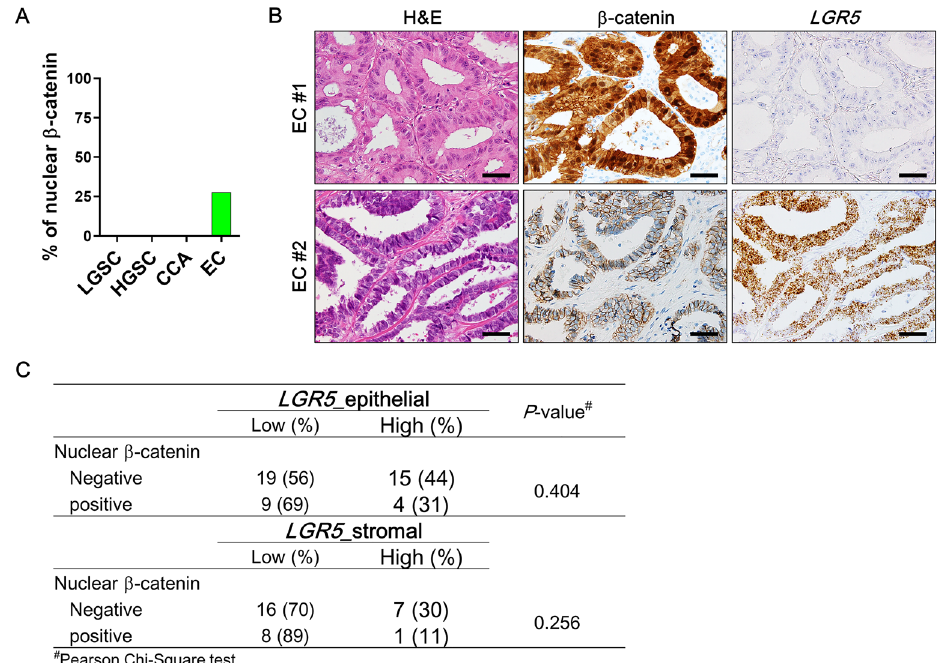
Figure 9. Association of LGR5 with β-catenin expression in endometrioid carcinomas (ECs). ( A ) A bar graph showing percentages of nuclear β-catenin expression in various ovarian carcinomas. ( B ) Representative images of a EC expressing nuclear β-catenin and no LGR5 (EC #1), and a EC expressing normal membranous β-catenin and strong LGR5 (EC #2). Scale bar, 50 µm ( C ) A table showing the correlations of epithelial or stromal